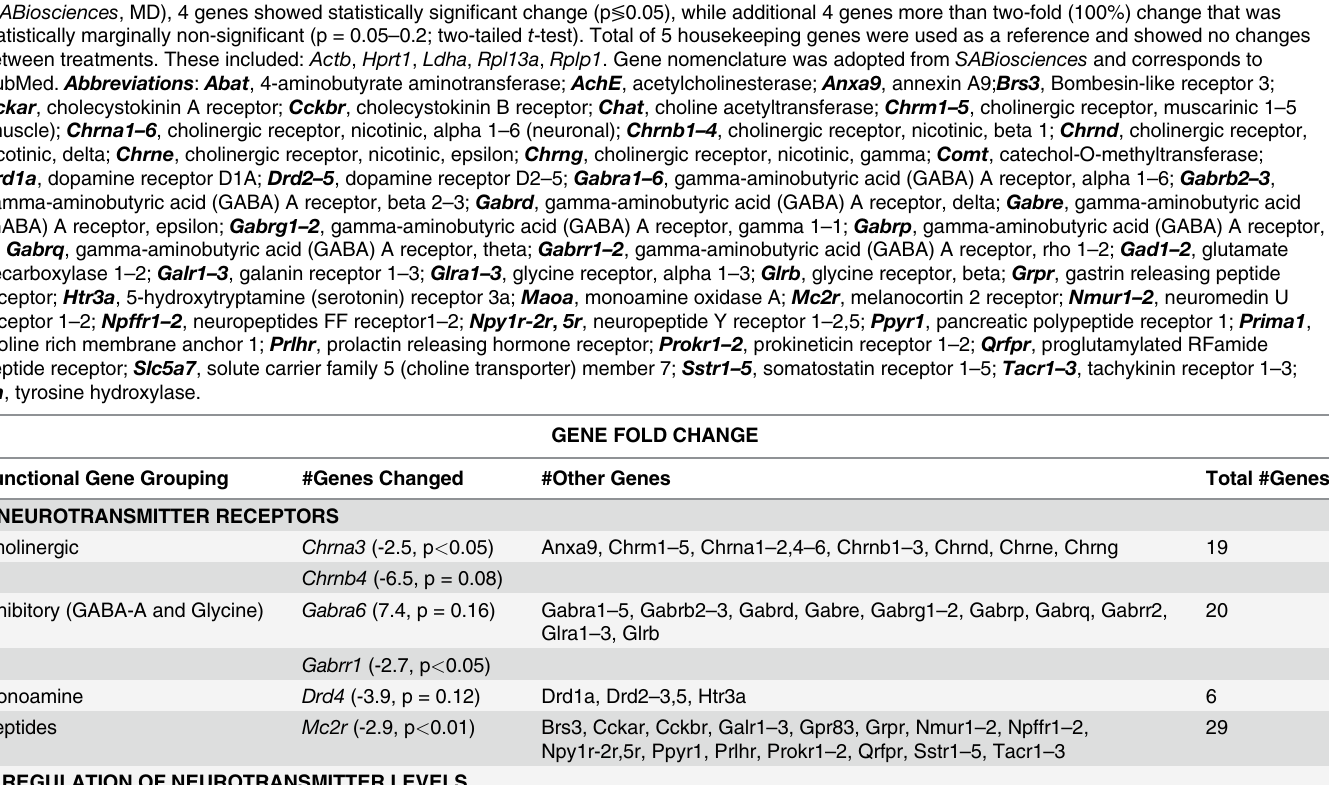
Table 1. Gene Expression Changes Using Neurotransmitter Receptors and Regulators PCR Array : Chronic Morphine vs. Saline Control Groups. Gene Expression Changes in Ventral and Ventrolateral Periaqueductal Gray with Chronic Morphine Treatment at the level of Inferior Colliculus (for anatomical location of region of analysis, see Fig. 1). Out of 84 total genes in the Neurotransmitter Receptors and Regulators PCR Array ( SABiosciences , MD), 4 genes showed statistically signi fi cant change (p ≶ 0.05), while additional 4 genes more than two-fold (100%) change that was statistically marginally non-signi fi cant (p = 0.05 – 0.2; two-tailed t -test). Total of 5 housekeeping genes were used as a reference and showed no changes between treatments. These included: Actb , Hprt1 , Ldha , Rpl13a , Rplp1 . Gene nomenclature was adopted from SABiosciences and corresponds